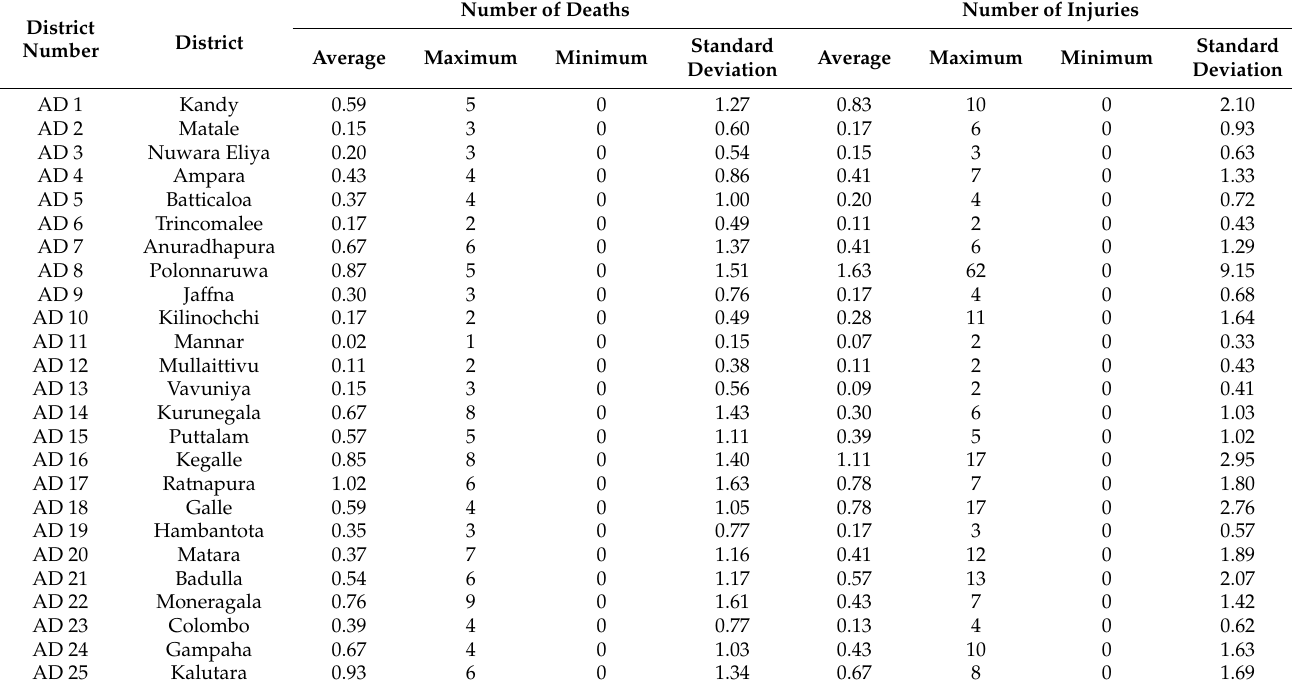
Table A1. Statistical variations of the deaths and injuries in each administrative district of Sri Lanka due to lightning, from 1974 to 2019.